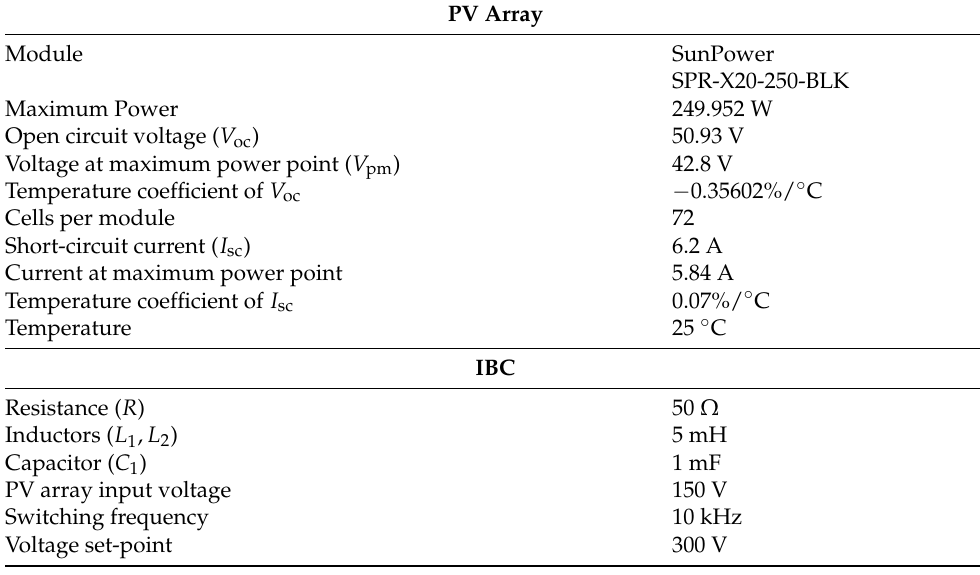
Table 2. Parameters of the selected devices considered for this work. The PV array is arbitrarily selected with illustrative purposes, while the IBC is defined based on Habib et al. [10]. PV Array